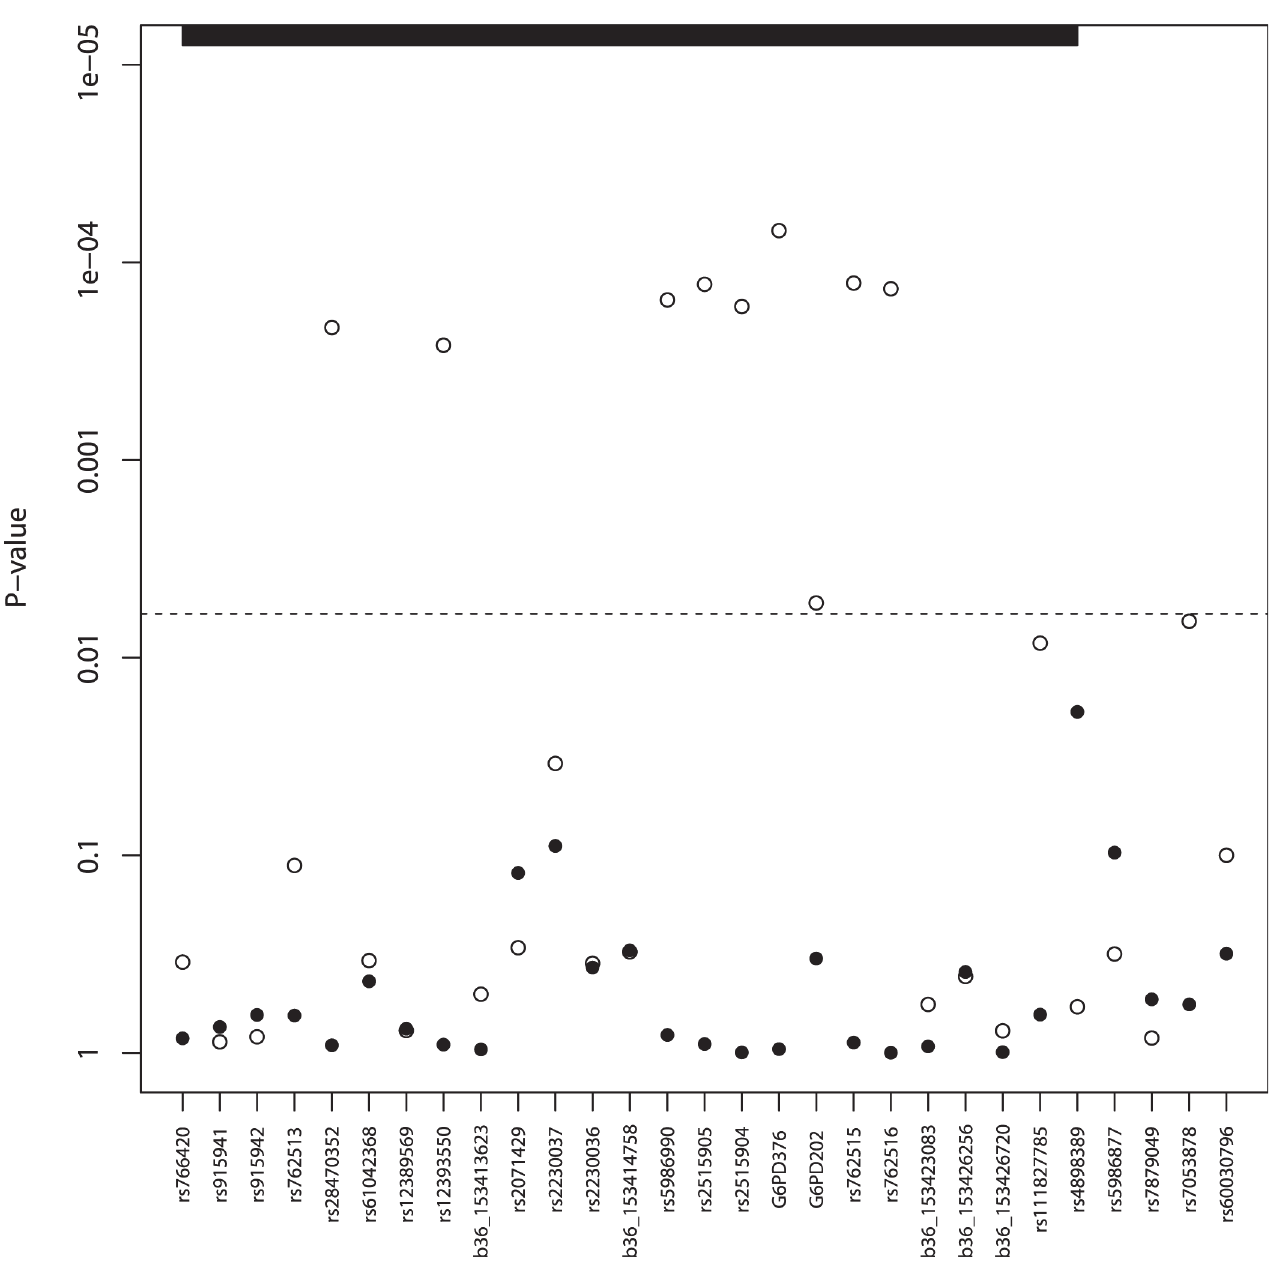
Fig 1. Severe malaria association results * (males — solid, females — hollow circles). * Minimum p-values from single SNP analysis adjusted for age and ethnicity. The dashed line represents a p-value cut-off of 0.006; the vertical dashed line represents a p-value cut-off of 0.006; the G6PD/IKBKG region is bolded on the right, and the 5 remaining SNPs are in the CTAG1A/B region.